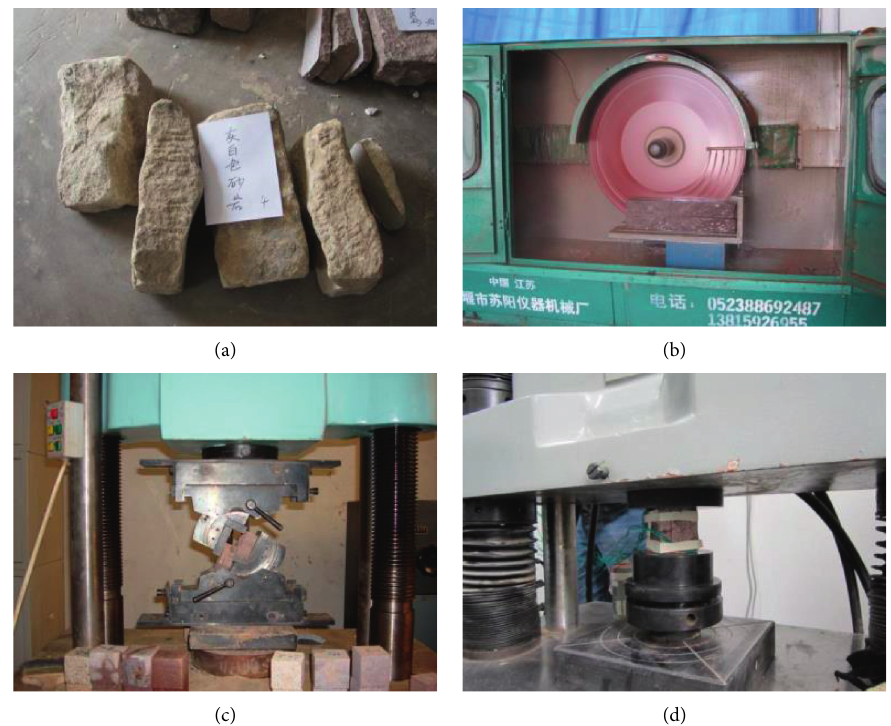
Figure 2: Rock mechanics experiment: (a) primary sample, (b) sample cutting, (c) rock shear test, and (d) uniaxial compression total of 20 small bolts. For the convenience of analysis, 5 diameter r � 12 mm; and design load is 40 kN. From the left rows of bolts were numbered as groups X1 to X5 from left to boundary of the model, a row of bolts was installed with an right along the x -axis. From low to high along the elevation interval of 2 m, 5 vertical rows, 4 bolts in each row, and a